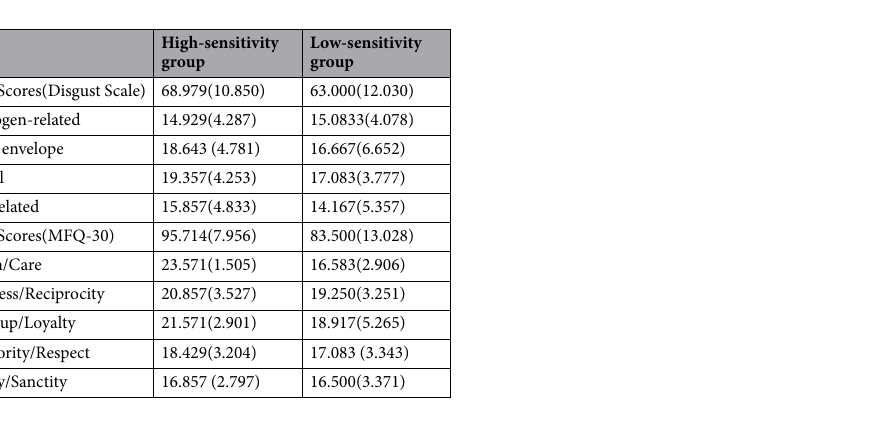
Table 1. Scores on the Moral Foundation Questionnaire and the Disgust Scale (mean and stand deviation) for the high-sensitivity group and the low-sensitivity